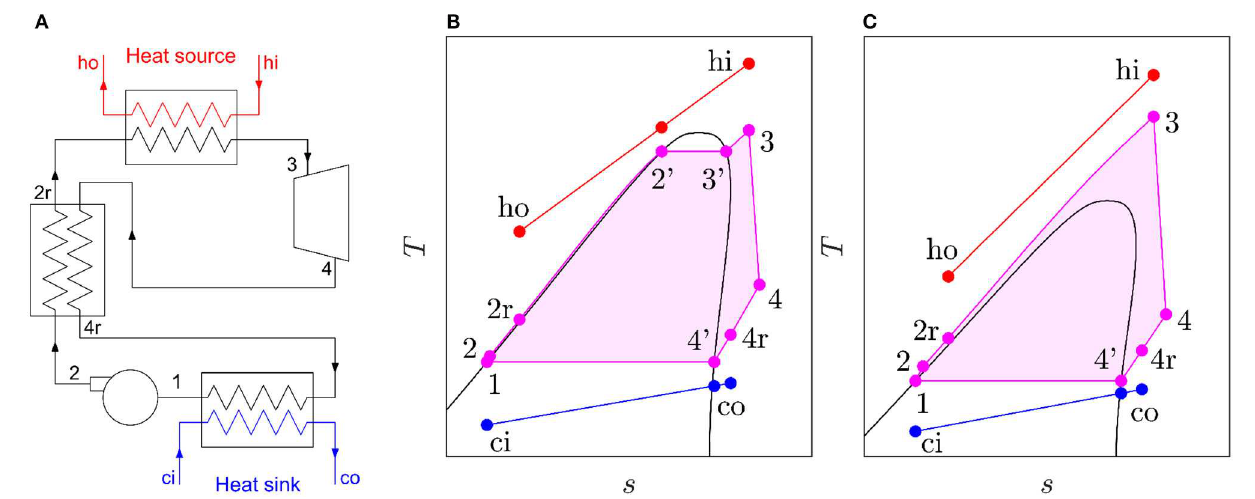
FIGURE 1 | Description of the ORC systems considered within this study: (A) schematic of a recuperated ORC system; (B) T - s diagram of a subcritical recuperated ORC system; and (C) T - s diagram of a transcritical recuperated ORC